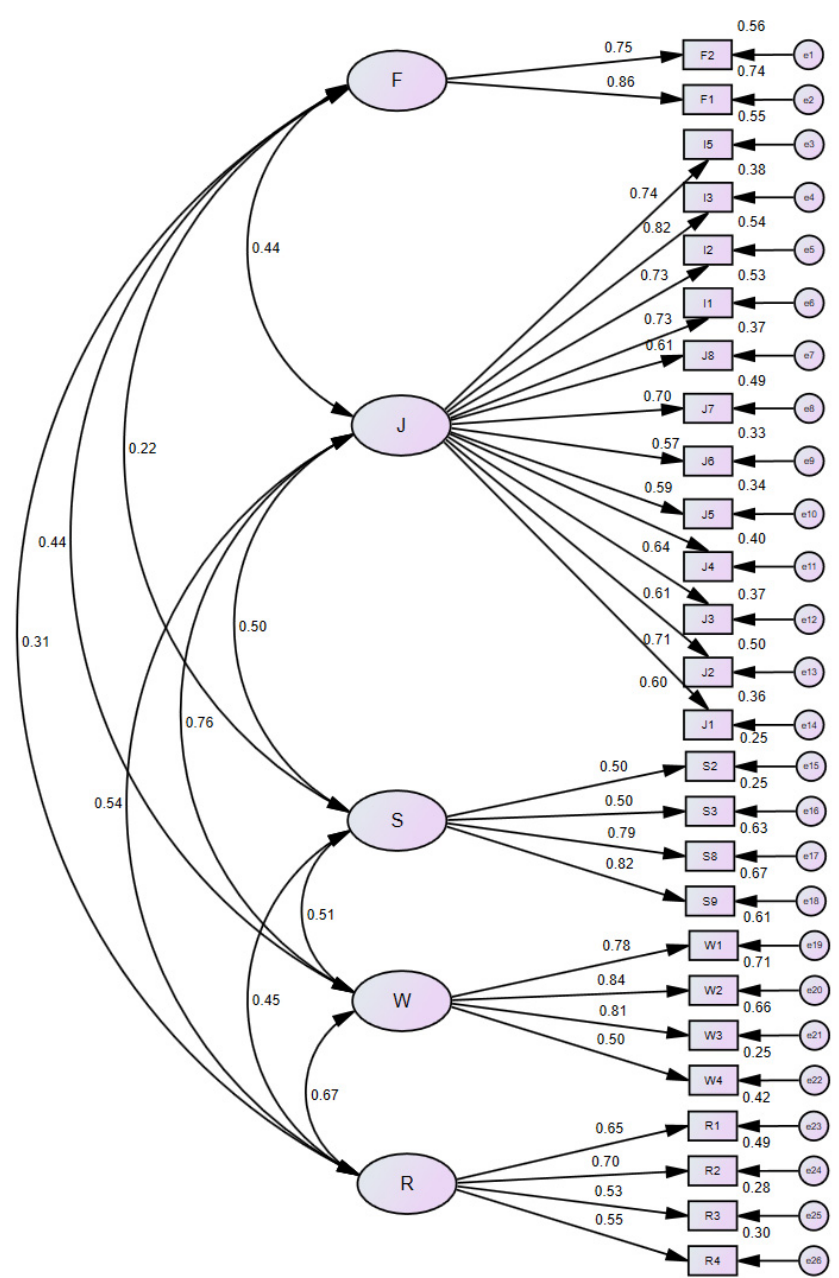
Figure 4. The Optimal Standardized Confirmatory Factor Analysis Model.